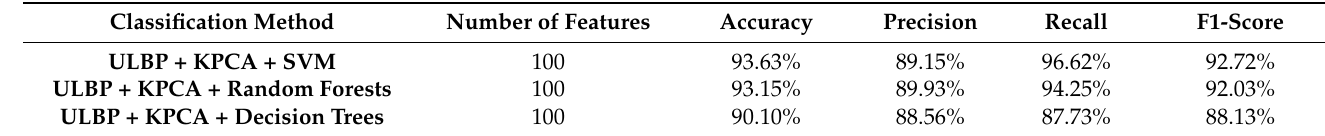
Table 6. Accuracy, Precision, Recall, and F1-scores using reduced ULBP features.